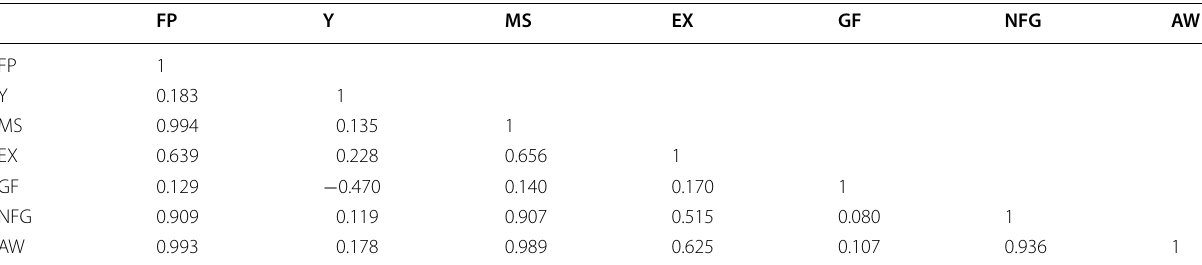
Table 2 Results of correlation matrix